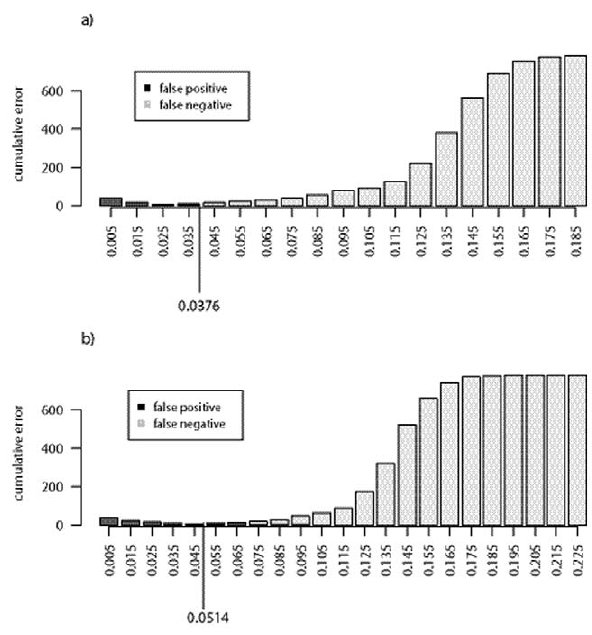
Figure 4. Distributions of the cumulative errors among the 40 species of Praomyini tribe, calculated from: (a) the CO1 gene; (b) the Cytb-part1 gene.